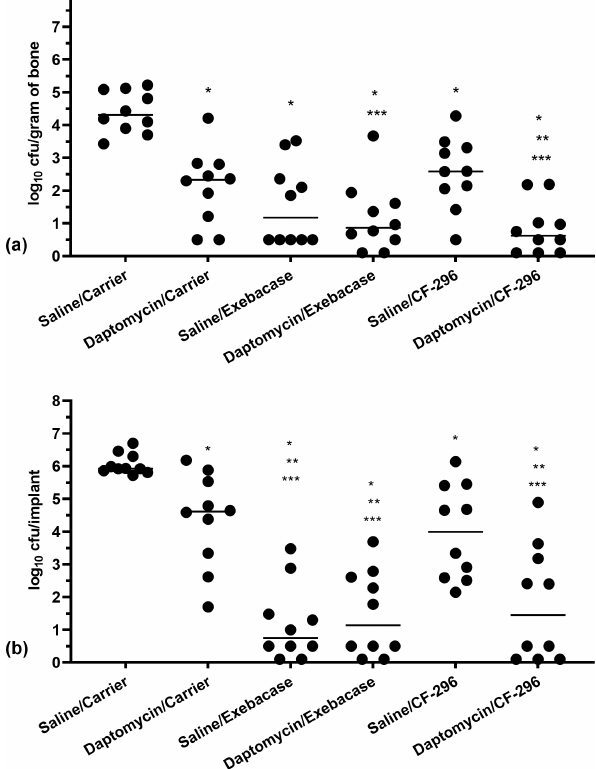
Figure 5. Quantities of MRSA recovered from bones (a) and implants (b) on day 5. Dots represent values from individ- ual animals; n = 10 per group; horizontal lines represent me- dian values. Asterisks indicate significant reductions compared to * saline/carrier ( P ≤ 0 . 0025), ** daptomycin/carrier ( P ≤ 0 . 0098), or *** saline/CF-296 ( P ≤ 0 . 0154). (Note that slashes depict the treatment grouping, with the top being the systemic treatment given daily and the bottom being the local treatment administered at the time of